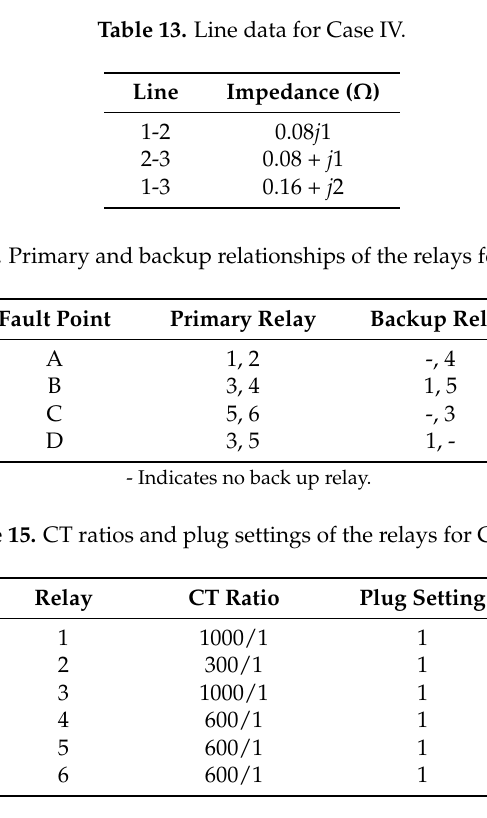
Table 16. a ρ Constants and relay currents for Case IV.